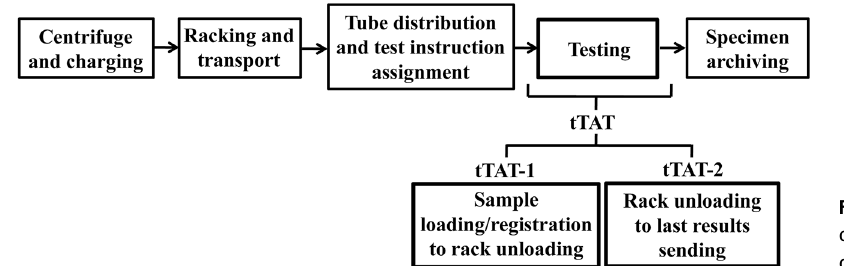
Figure 2: The workflow in our clinical chemistry laboratory and the flow dissections of